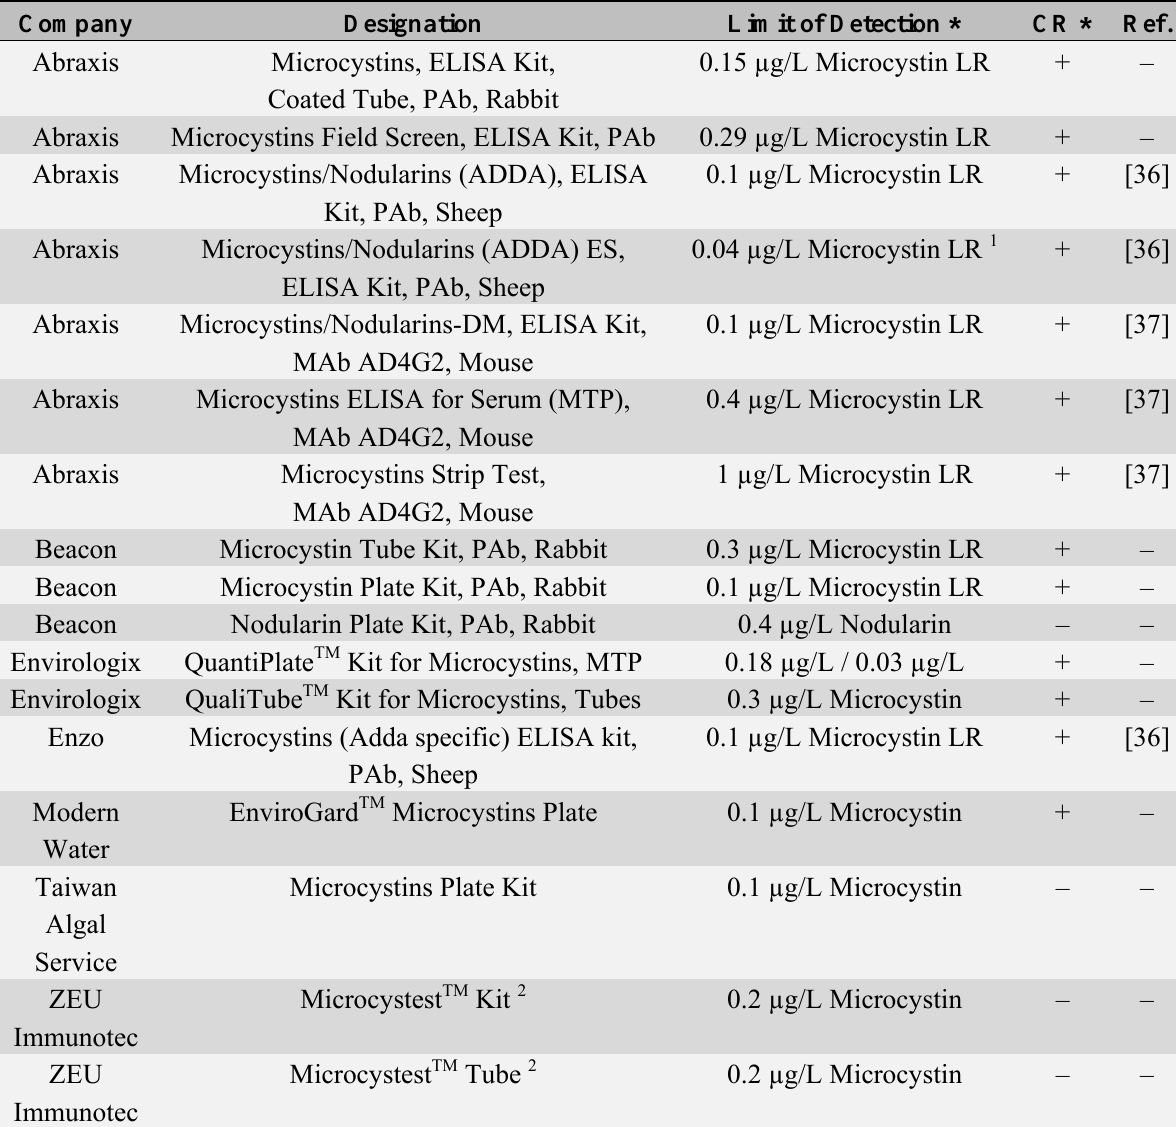
Table 1. Commercial immunoassays against microcystins and